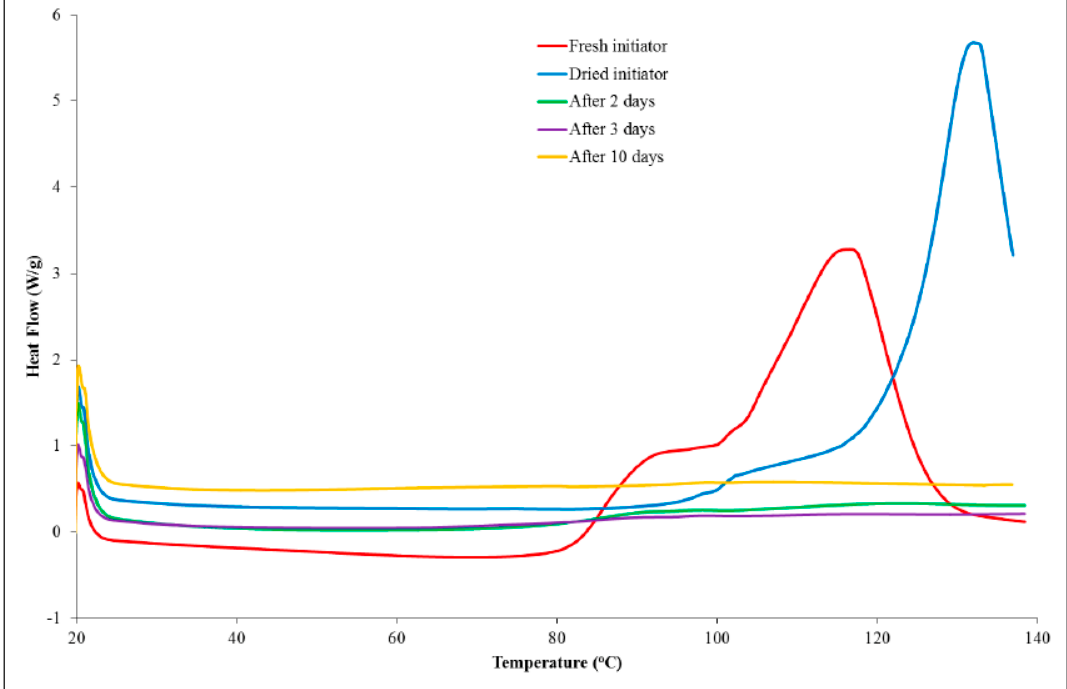
Figure 5. Dynamic DSC data for formulations comprising PGE (5 g) and dried or exposed 1-ethyl-3-methylimidazolium acetate (0.25 g).